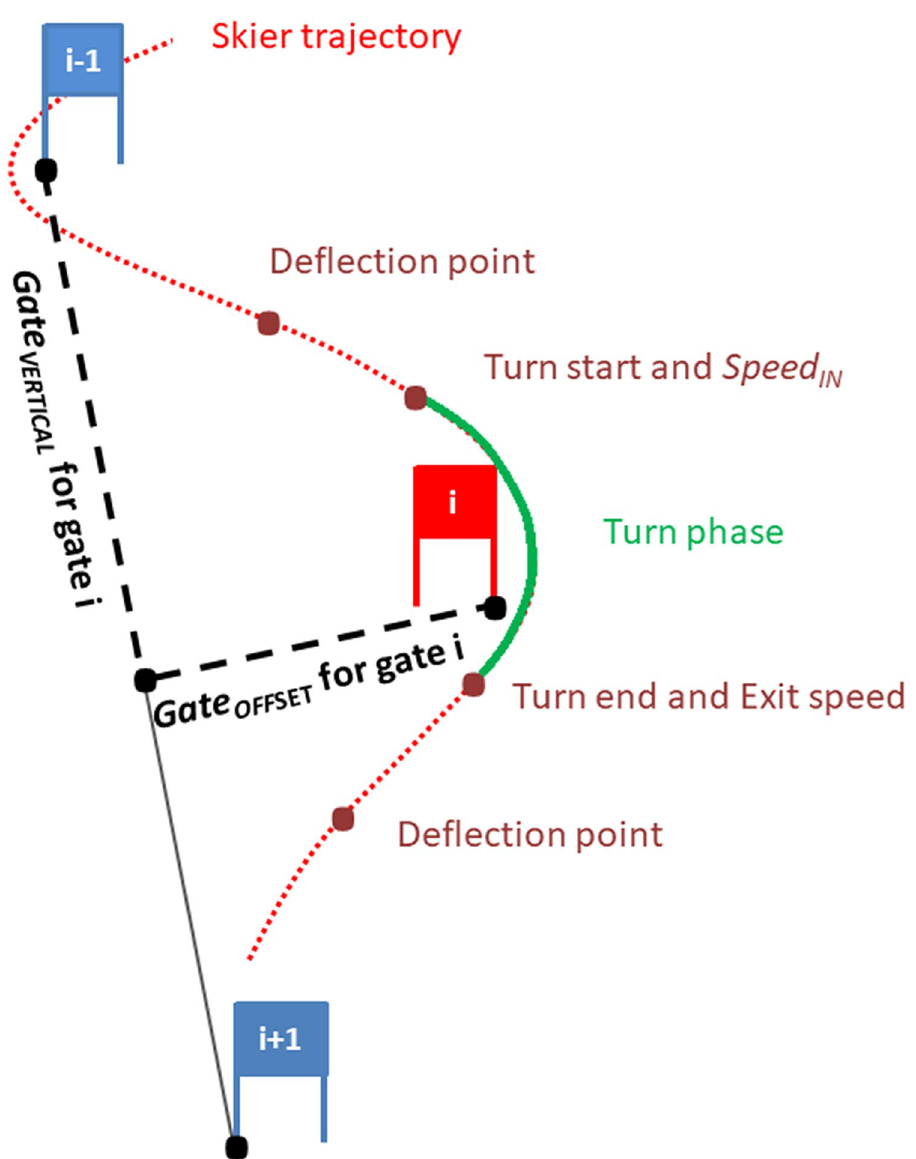
Figure 1. Definition of the course setting characteristics in black: vertical gate distance ( Gate VERTICAL ) and gate offset ( Gate OFFSET ). The turn phase is colored in green. In red: turn phase starts within two deflection points and starts where the center of mass turn radius drops below 75 m and ends where the center of mass turn radius exceeds 75 m. Speed at turn start ( Speed IN ) and turn exit speed are measured at turn start and turn